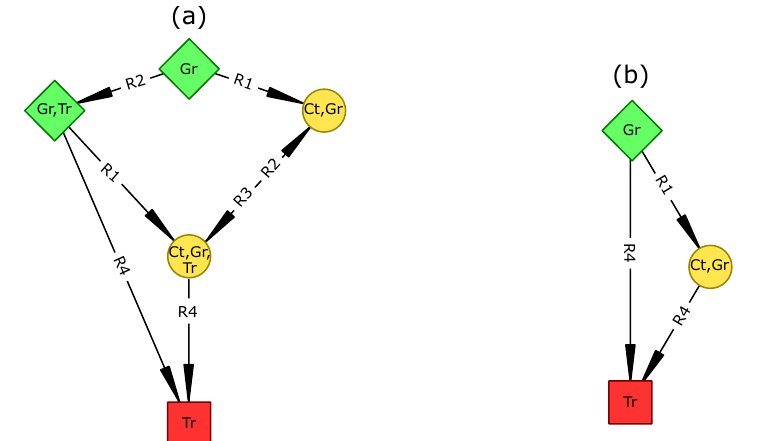
Figure A3. Comparison between the STG and HTG of the “Grasses-Trees-Cattle” toy model. ( a ) This STG is the same as Figure 1a and rules are those from Table 1. In ( b ), green lozenges nodes belong to a basin, yellow round nodes belong to a SCC and the red square node to a stable state (i.e., a basin of attraction of one state). ( b ) The HTG resulting from the merging of corresponding nodes in ( a ) into a single node. Hence the green lozenge and yellow round nodes include two states each and their “internal” transitions (e.g., the R2-R3 oscillation) are “hidden” within them. Node labels correspond to active variables Gr : Grasses, Tr : Trees, and Ct : Cattle. Note that in ( b ) node labels correspond to variables that are present in all states of the topological structure (i.e., SCC, basin or stable state). For instance, Tr oscillates in the yellow SCC in ( a ) and is thus not mentioned in the corresponding yellow node in ( b ).